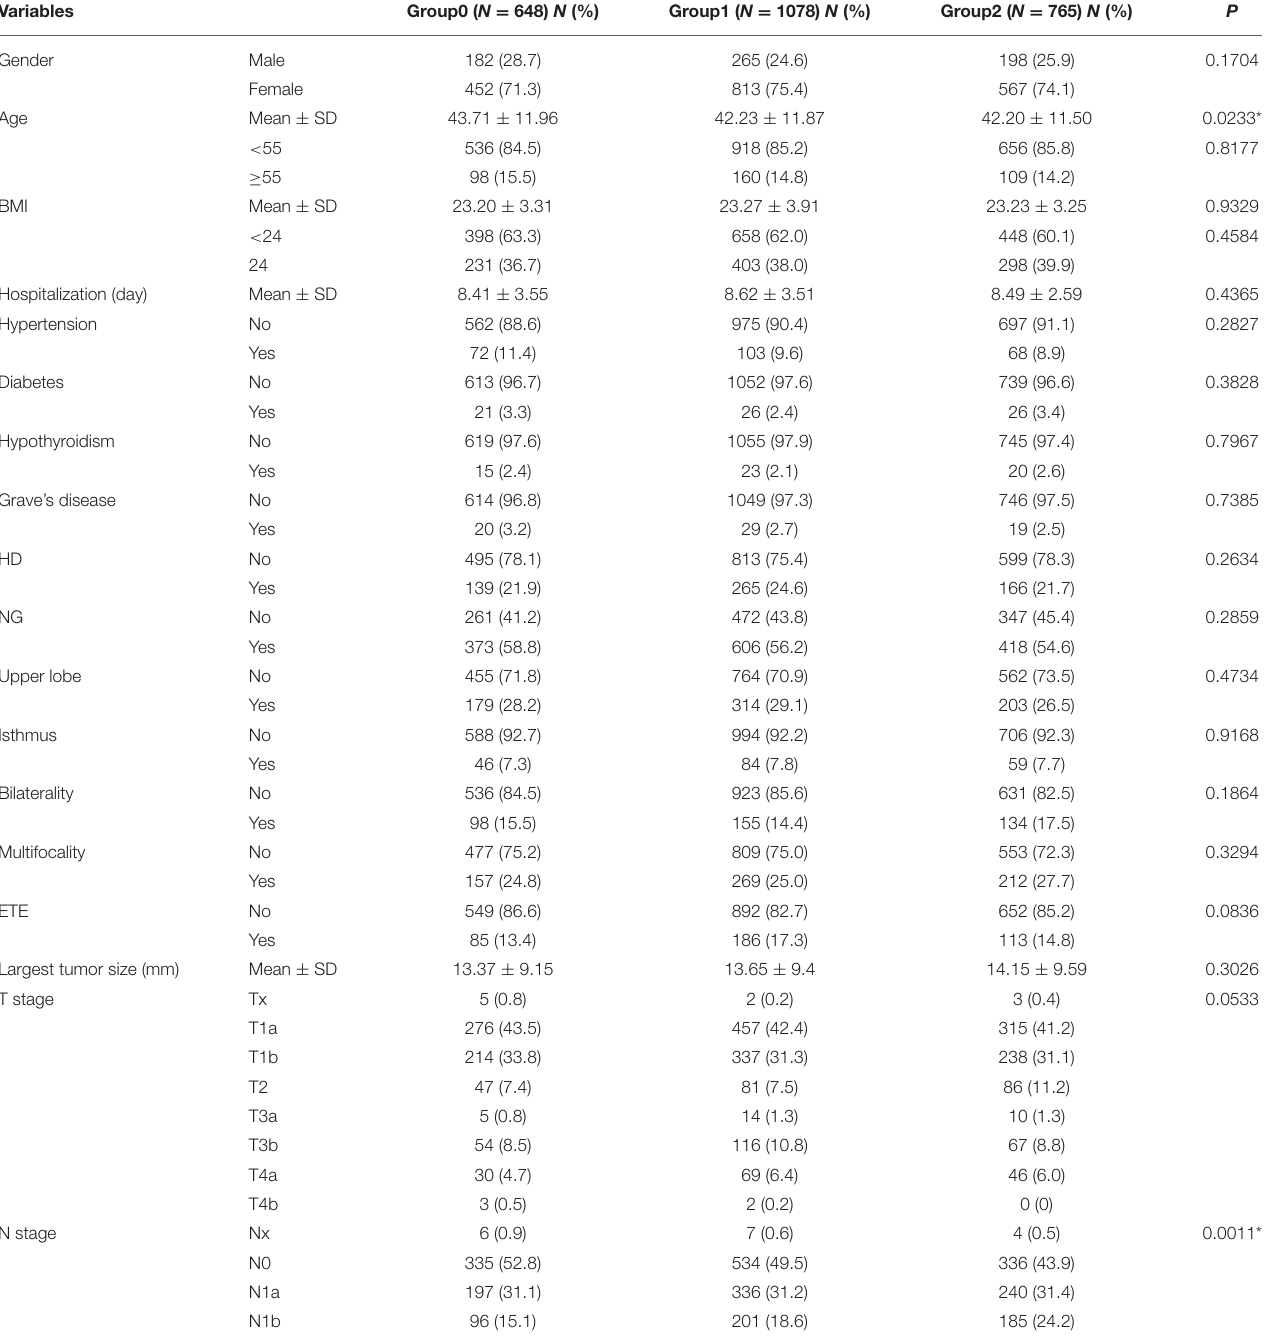
TABLE 1 | Basic characteristics of included